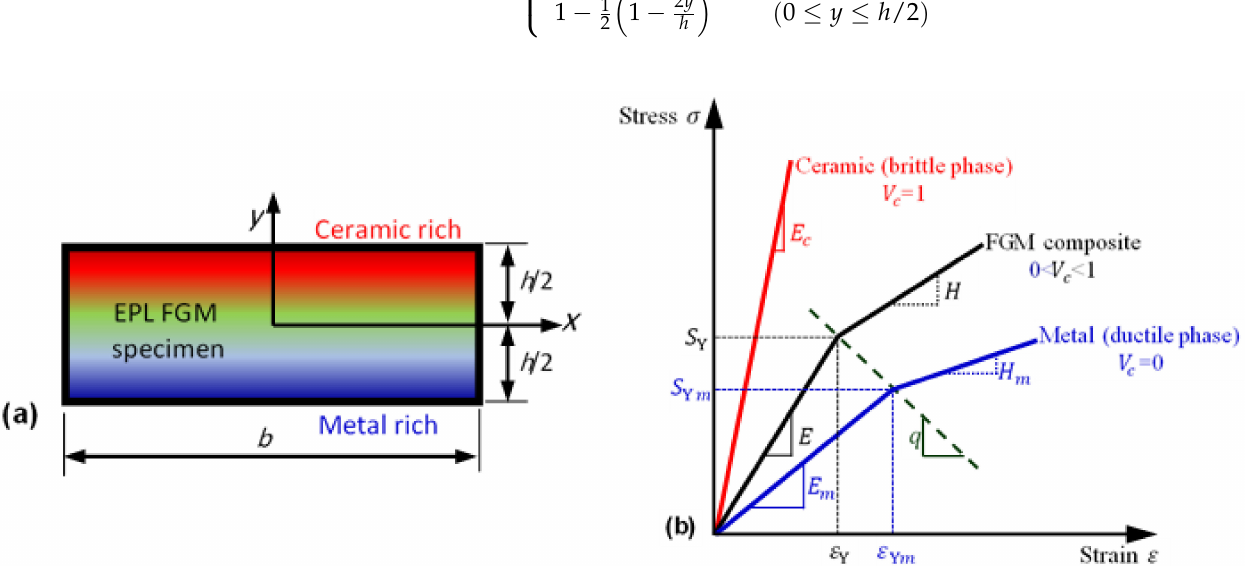
Figure 1. Typical stress–strain curve for a bilinear elastoplastic material FGM based on TTO model. ( a ) Coordinate system of material gradation, ( b ) Effective constitutive relation for